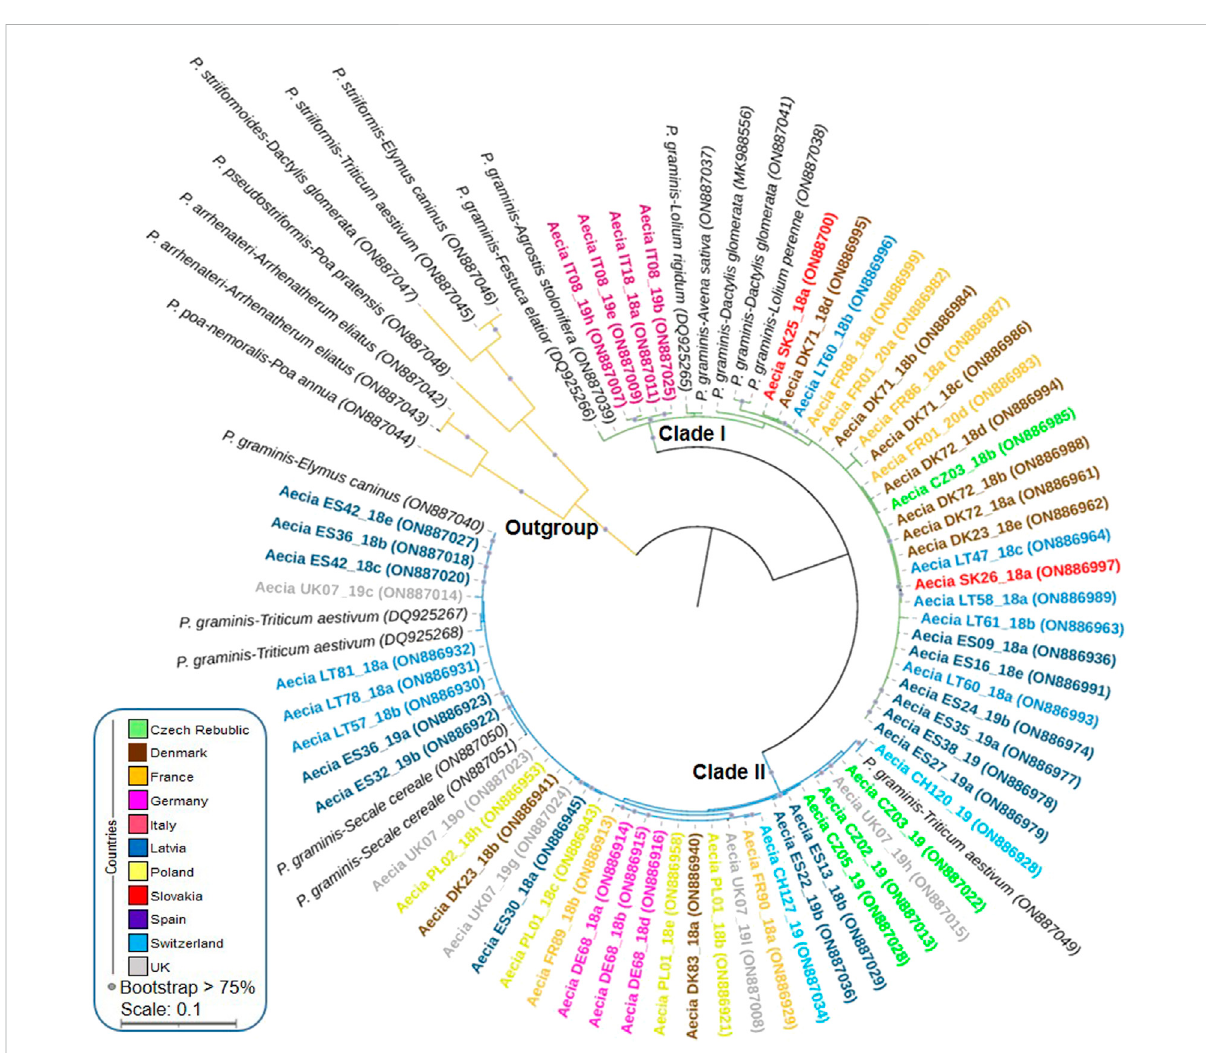
FIGURE 2 Phylogenetic analysis of the elongation factor 1- α (EF1- α ) gene ampli fi ed for 61 aecial samples collected in 11 European countries and 20 Puccinia graminis and P. striiformis reference isolates collected from multiple cereals and grasses (accession numbers from NCBI). Sequences from P.striiformis andrelatedspecies wereincluded asanoutgroup.Bootstrapvaluesfor1,000 replicatesareshownwhen > 75%.Scalebarindicates nucleotide substitutions per site.